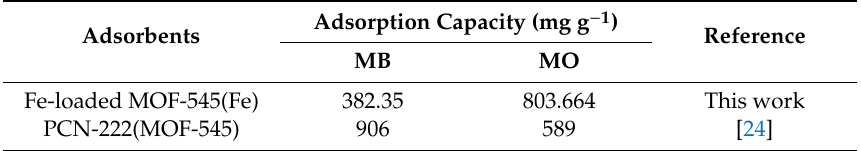
Table 2. Comparison of absorption capacity of MB and MO by Fe-loaded MOF-545(Fe) and reported